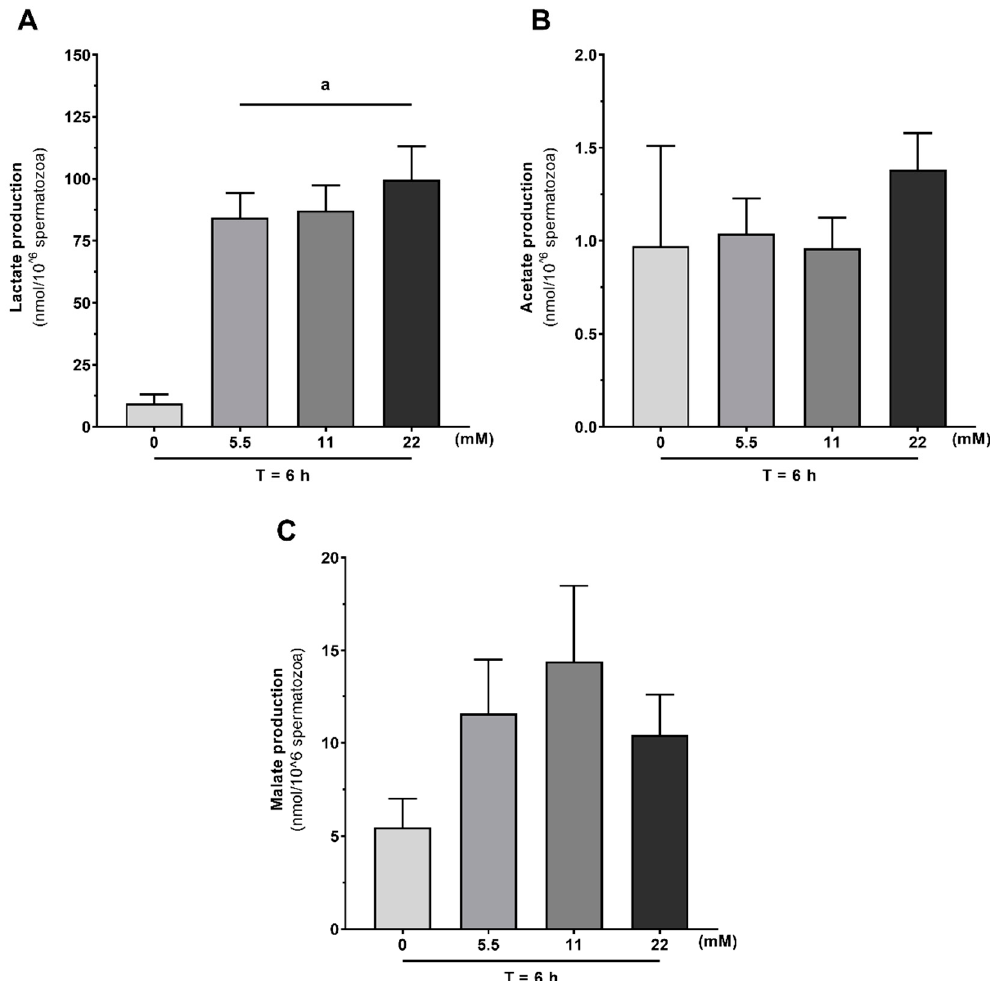
Figure 3. Production of lactate ( A ), acetate ( B ), and malate ( C ) by human spermatozoa 6 h after incubation without or with glucose (0, 5.5, 11, and 22 mM) under capacitation conditions. Results are expressed as mean ± SEM ( n = 15 for each condition). Significantly different results are expressed as: ( a ) Relative to 0 mM glucose group (T = 6 h).